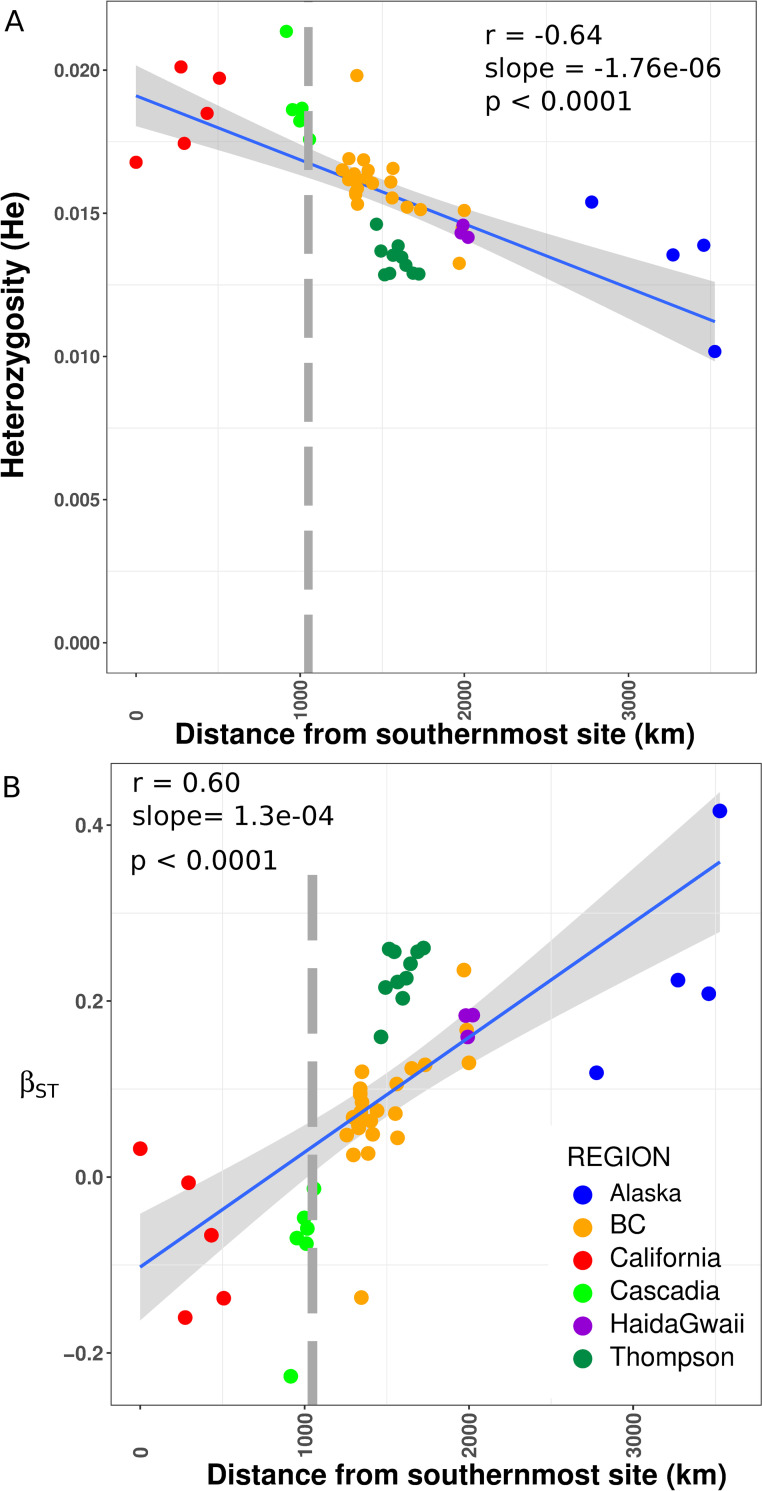
Genetic diversity and differentiation.A) Linear relationship between expected heterozygosity and distance from the southernmost population located in California. B) Linear increase in genetic differentiation as measured by βST as a function of the distance from the southernmost population located in California. Negative values indicate the most likely ancestral population. The relationship in A and B was tested using linear models. The grey vertical bar in panel A and B indicates the approximate location of the southern limit of the ice-sheet at the end of the last glacial maximum. The coefficient of correlation (r) is indicated for each plot. The grey shaded area along the regression line corresponds to the 95% confidence level interval obtained from the linear models applied to each dataset.